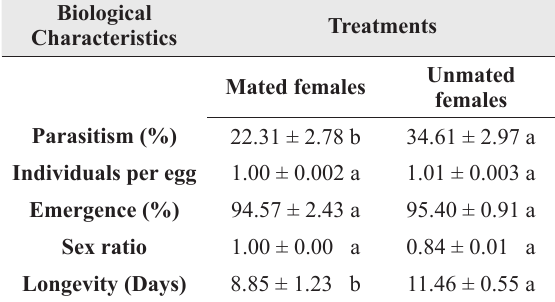
Interference of mating on the biological characteristic of the population of Trichogramma pretiosum (Hymenoptera: Trichogrammatidae) collected in the Means ± SE followed by the same letter in the line are statistically similar according to the t-test (sig. = 0.05).